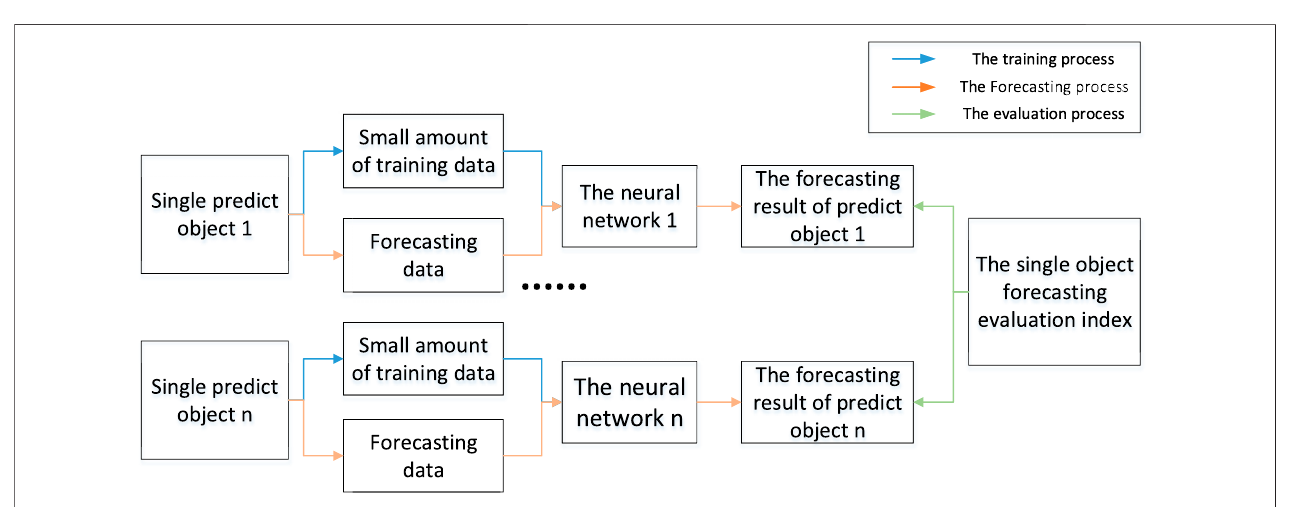
FIGURE 7 | Forecasting fl ow chart of Single Object — Single Forecasting model.